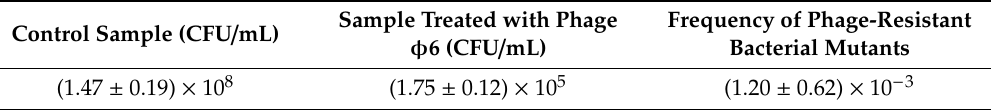
Table 3. Frequency of emergence of P. syringae pv. syringae spontaneous phage-resistant mutants.